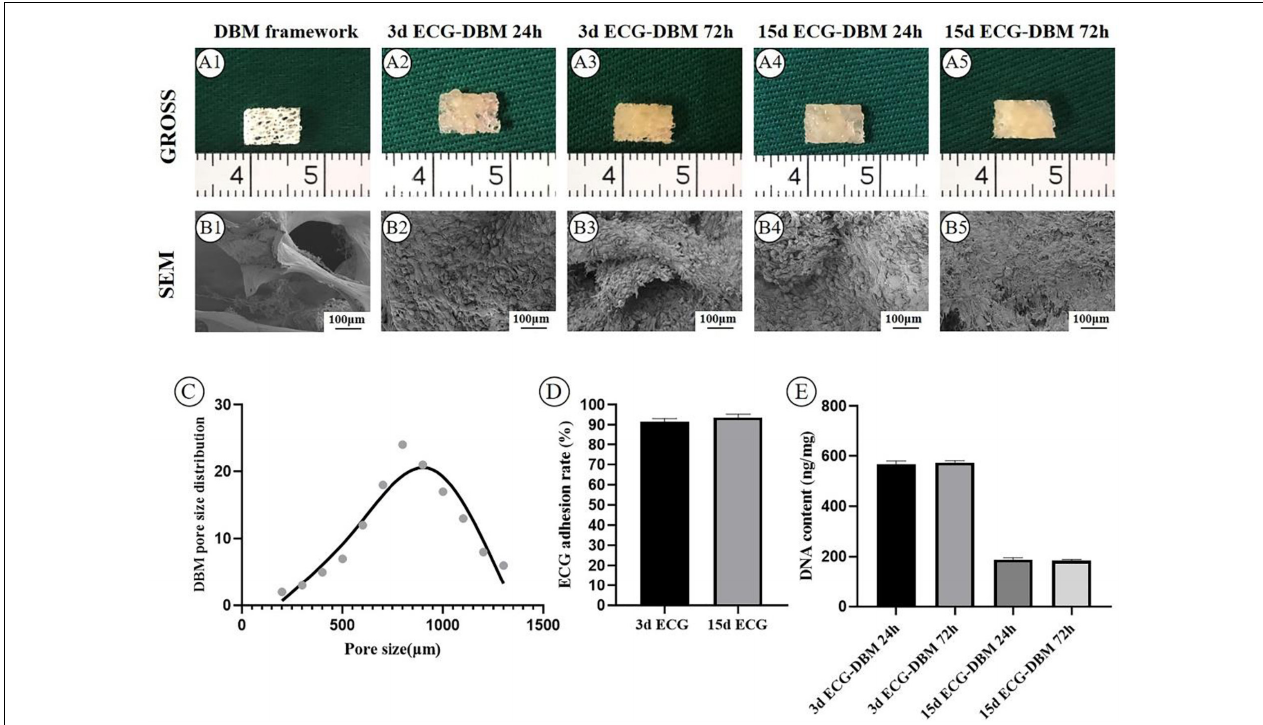
FIGURE 2 | Evaluation of the biocompatibility of engineered cartilage gel (ECG) and decalcified bone matrix (DBM), and the ECG adhesion efficiency. Gross (A1) and SEM (B1) images of the DBM framework. Gross (A2) and SEM (B2) images of the 3 d ECG–DBM constructs after culture in vitro for 24 h. Gross (A3) and SEM (B3) images of the 3 d ECG–DBM constructs after culture in vitro for 72 h. Gross (A4) and SEM (B4) images of the 15 d ECG–DBM constructs after in vitro culture for 24 h. Gross (A5) and SEM (B5) images of the 15 d ECG–DBM constructs after in vitro culture for 72 h. The pore size distribution of the DBM framework (C) . The ECG adhesion rate of ECG (D) . The DNA content of the ECG–DBM framework at different times (E)